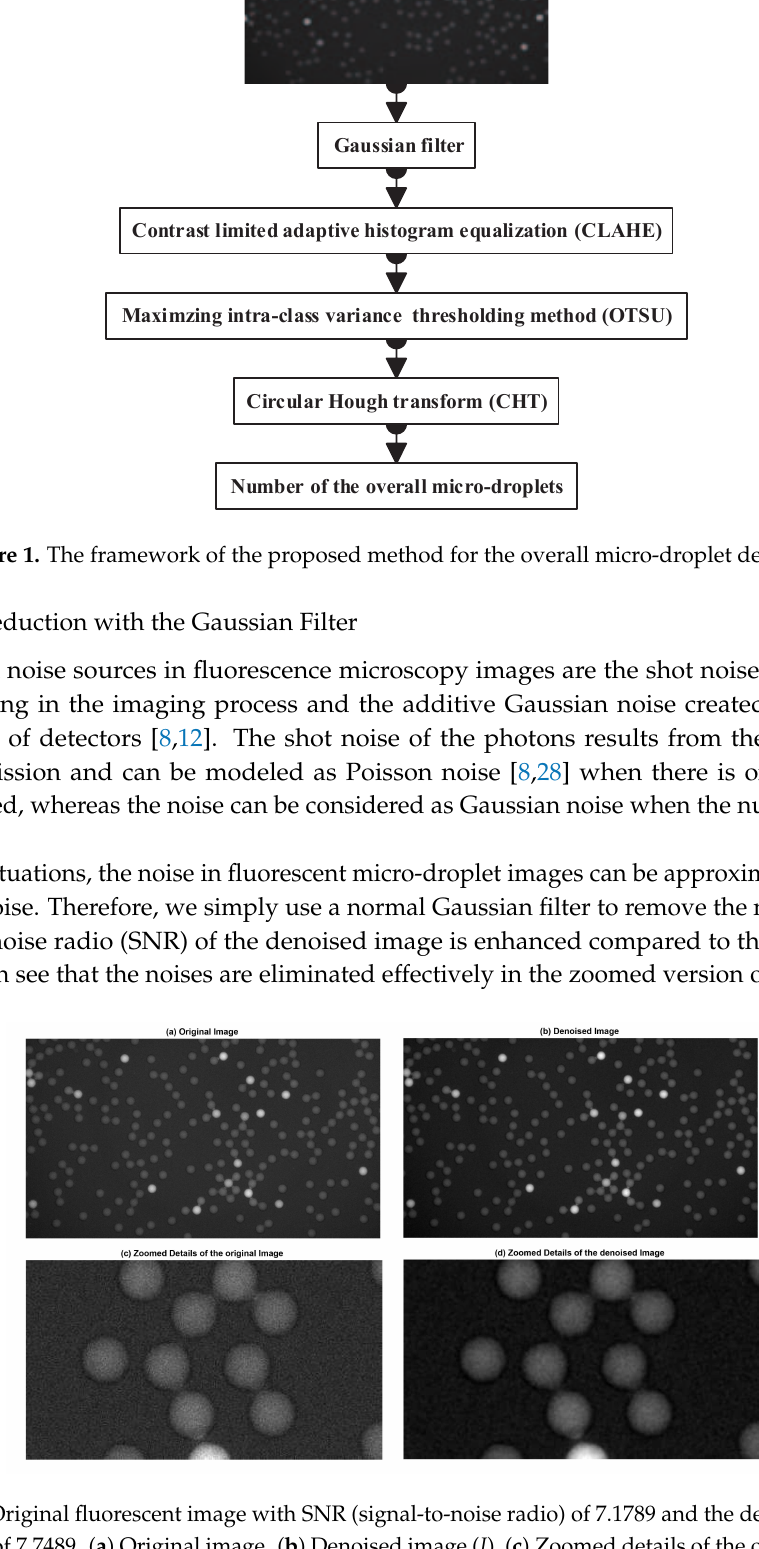
Figure 2. Original fluorescent image with SNR (signal-to-noise radio) of 7.1789 and the denoised image with SNR of 7.7489. ( a ) Original image. ( b ) Denoised image ( I ). ( c ) Zoomed details of the original image. ( d ) Zoomed details of the denoised